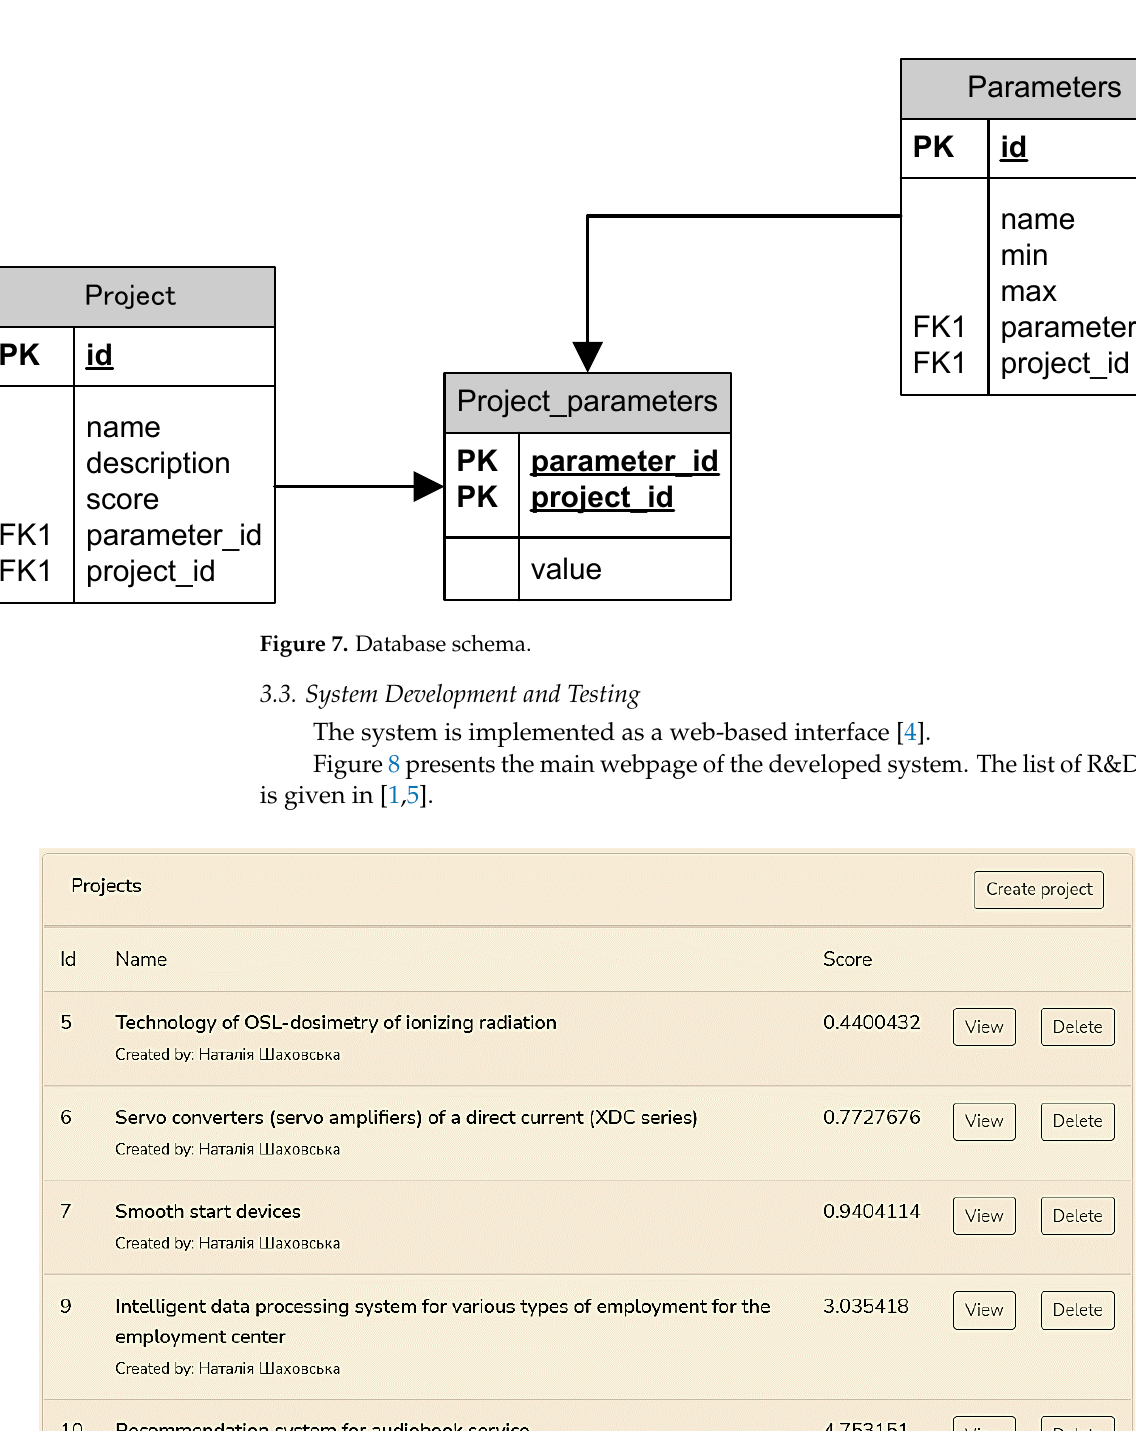
Figure 8. The main page of the information technology.